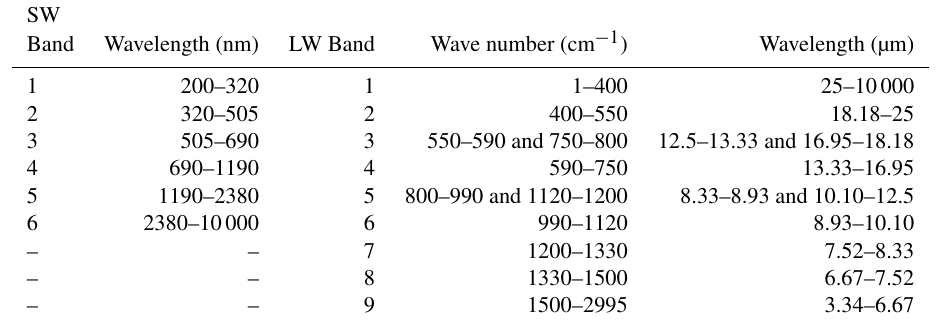
Table 2. Spectral bands for the treatment of incoming solar (SW) radiation (left) and thermal (LW) radiation (right).